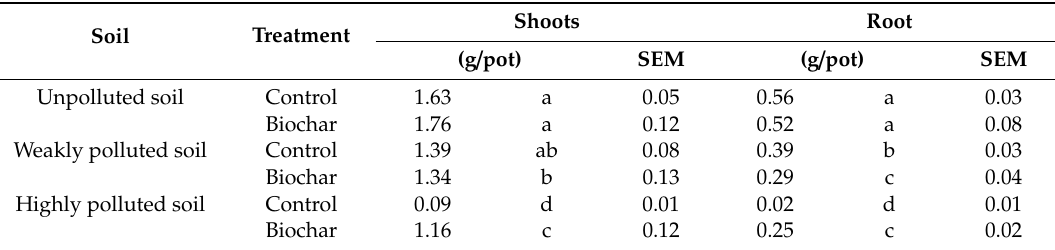
Table 2. Biomass of shoots and roots of barley grown in three di ff erently polluted soils amended or not with biochar (2% by weight). Soil